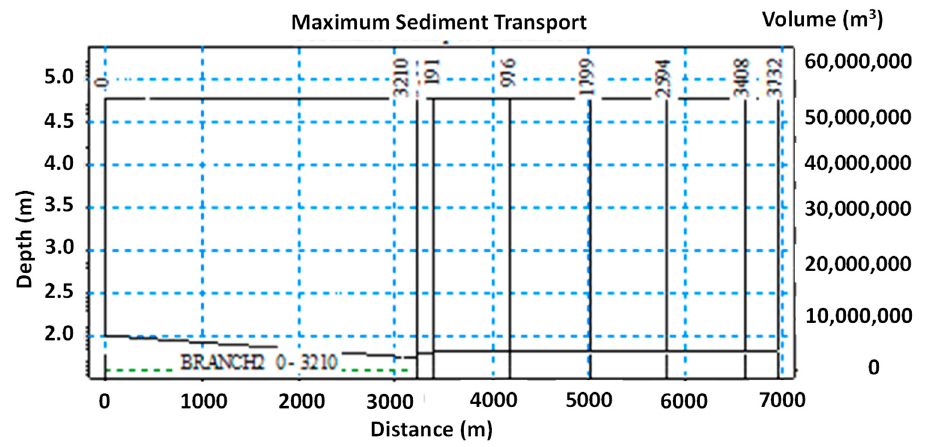
Figure 7. Sediment movement in RC without flap-gate .